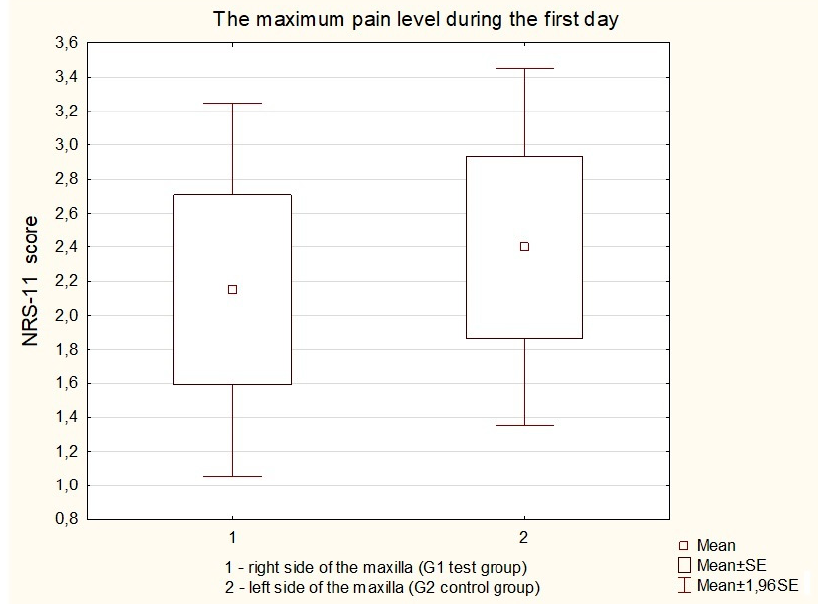
Figure 5. The maximum pain level during the first day after mini-implant insertion measured on the NRS-11 scale.